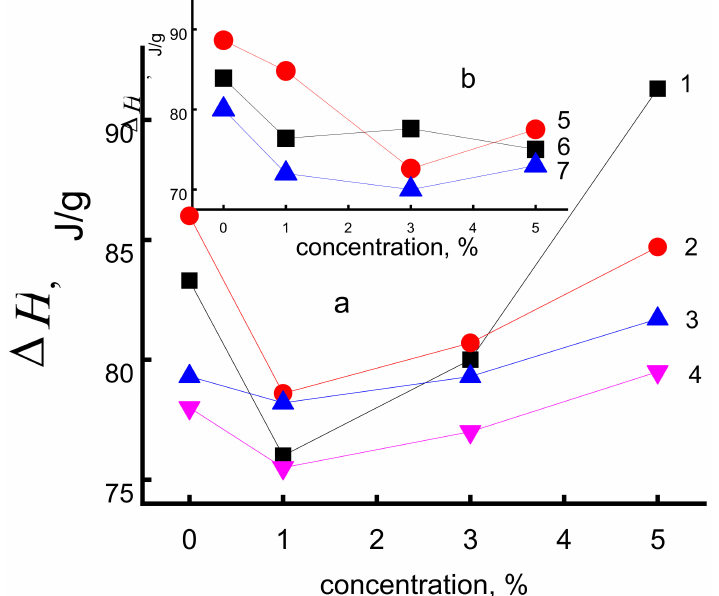
Figure 9. Dependence of melting enthalpy on the SnCl 2 -TPP ( a ) and TPP ( b ) content. Durability of water treatment (in min) at 70 ◦ C: 1—0, 2—30, 3—120, 4—240, 5—0, 6—120,